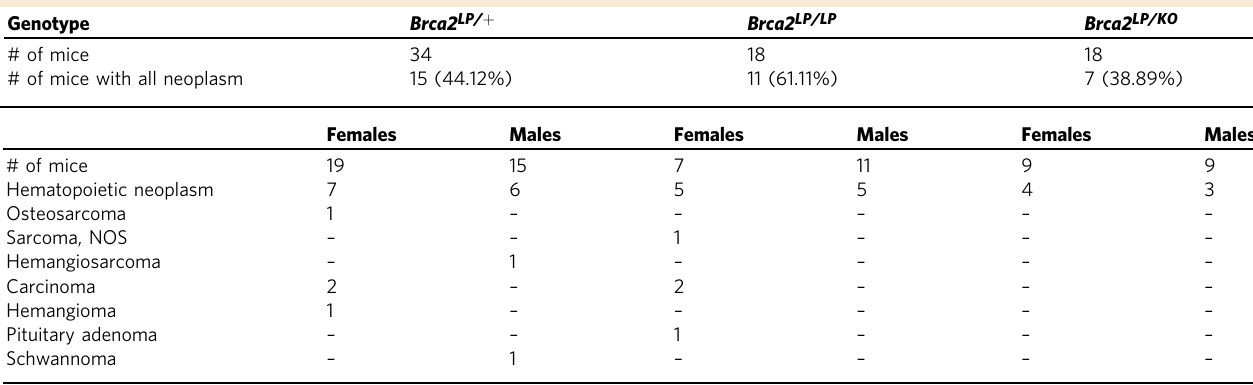
Table 3 Tumor incidence and spectrum of Brca2 LP/ + , Brca2 LP/LP , and Brca2 LP/KO